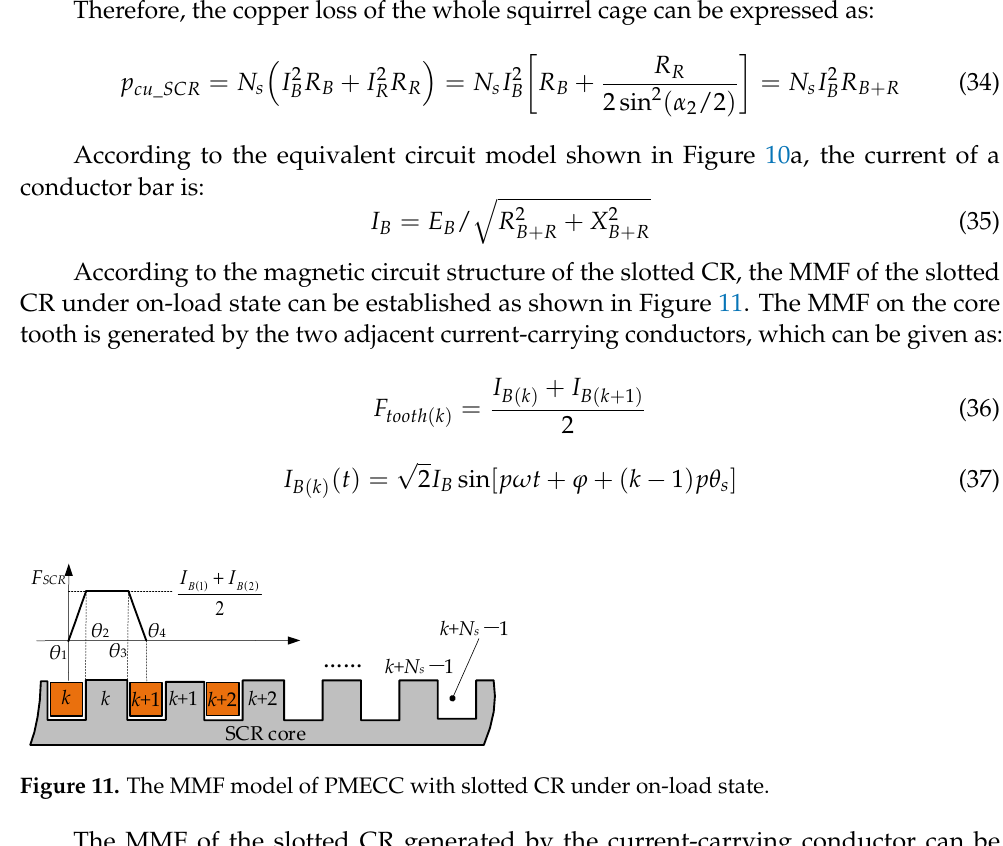
Figure 10. The equivalent circuit model of the PMECC with slotted CR: ( a ) equivalent circuit; ( b ) current vector diagram.